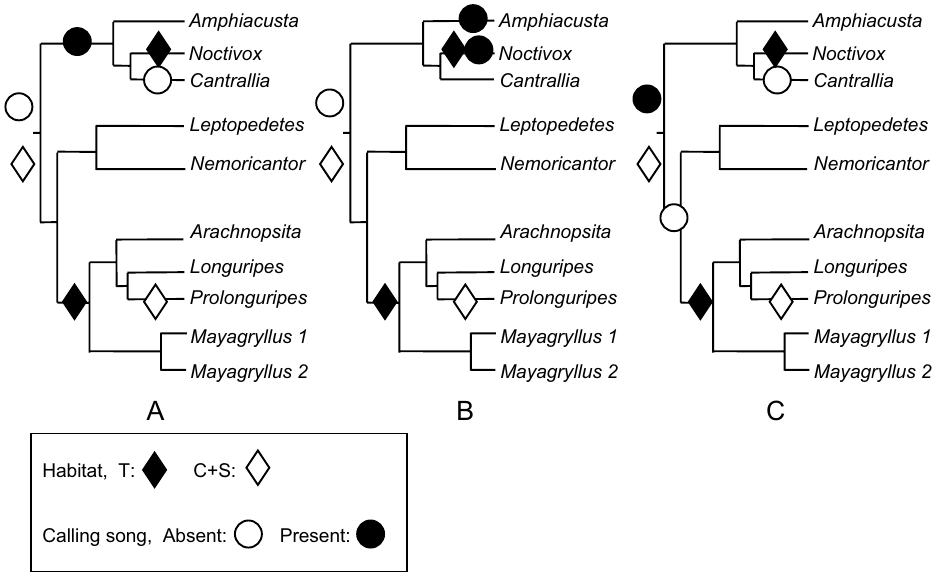
Fig. 5 – Evolution of habitats and songs inAmphiacustae crickets. (A, B, C), alternative equi-parsimonious scenarios. Abbreviations: C+S, cavicolous + straminicolous. T: troglobitic. After Desutter-Grandcolas (1993, 1997b,